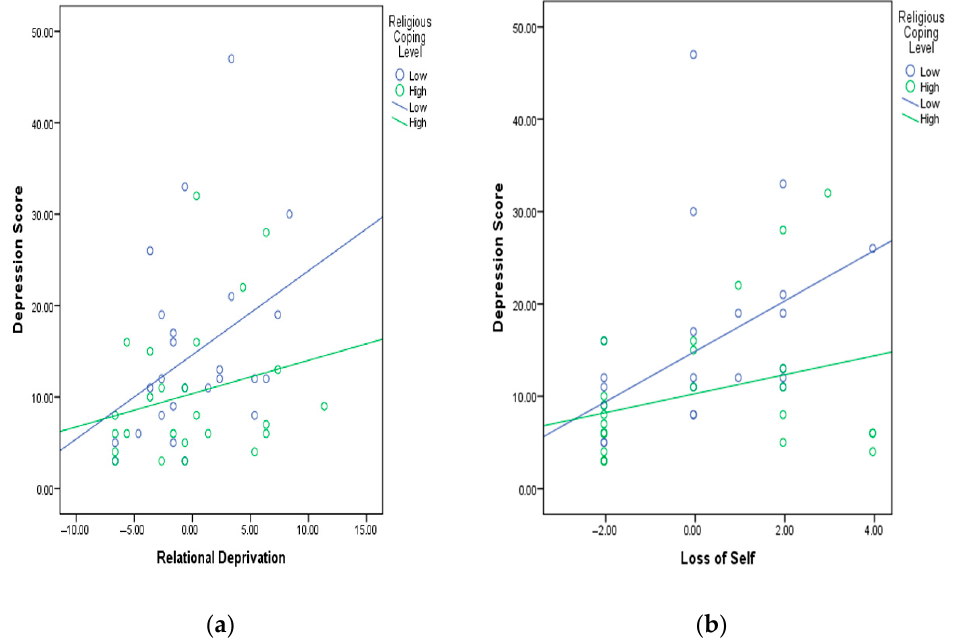
Figure 2. ( a ) Effect of religious coping on the relation between relational deprivation and depression; ( b ) effect of religious coping on the relation between loss of self and